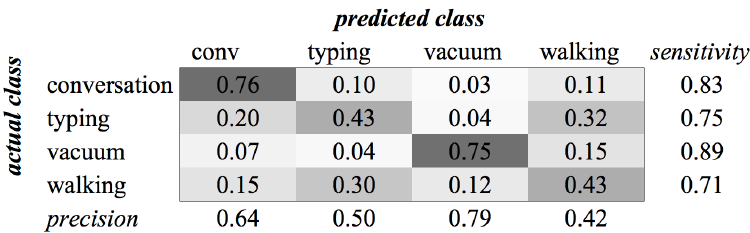
Figure A15. SVM confusion matrix of category Office for MFCC feature type.